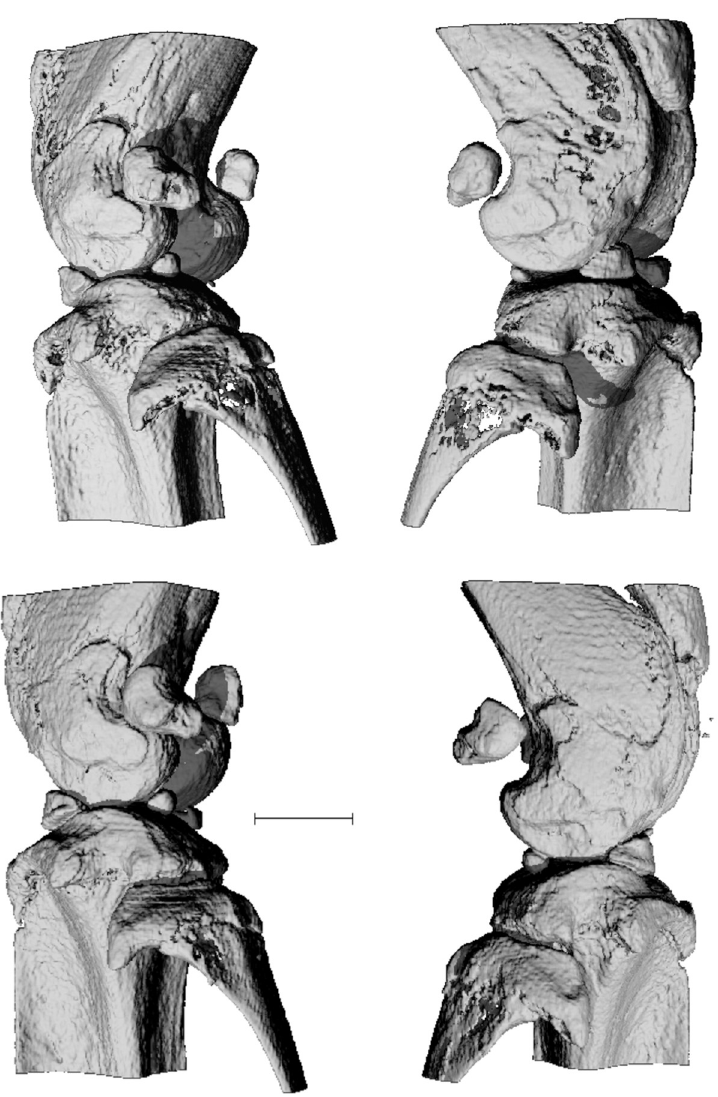
Fig 6. P . gingivalis mediated loss of trabecular bone can be seen in three-dimensional μ CT reconstructions of knee joints from DR4-bearing mice. B6.DR4 mice were repeatedly inoculated with P . gingivalis while control mice were left untouched as described in the Materials and Methods section. Following sacrifice, whole legs were subjected to μ CT analysis. Bone loss is especially apparent in fibula head for both the left knee (see also S3 Fig) and the right knee (see also S4 Fig) (top row) of a mouse treated with P . gingivalis relative to a left knee (see also S5 Fig) and a right knee (bottom row) from control B6.DR4 mice. These data are more easily visualized in animations made from the knees above that are provided as supplemental files. bar =